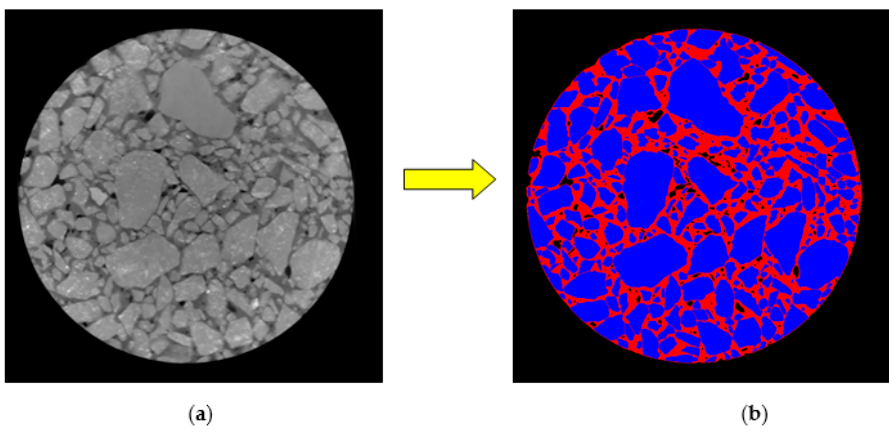
Figure 6. Phase-segmented image: ( a ) scanned CT image; and ( b ) phase-segmented image.